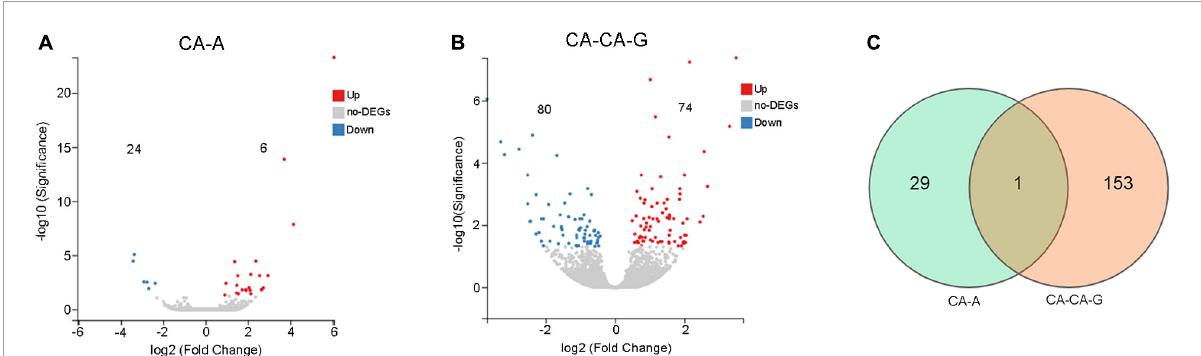
FIGURE5 The number of differentially expressed genes. (A) The volcano plots of the DEGs in CA-A. Significant differentially expressed genes were treated with red dots (upregulated) or blue dots (downregulated). (B) The volcano plots of the DEGs in CA-G. Significant differentially expressed genes were treated with red dots (upregulated) or blue dots (downregulated). (C) Venn diagram of differentially expressed genes. The number in each circle represents the total number of DEGs in each sample, and the overlapping part of the circles indicates that the DEG is shared in both samples.